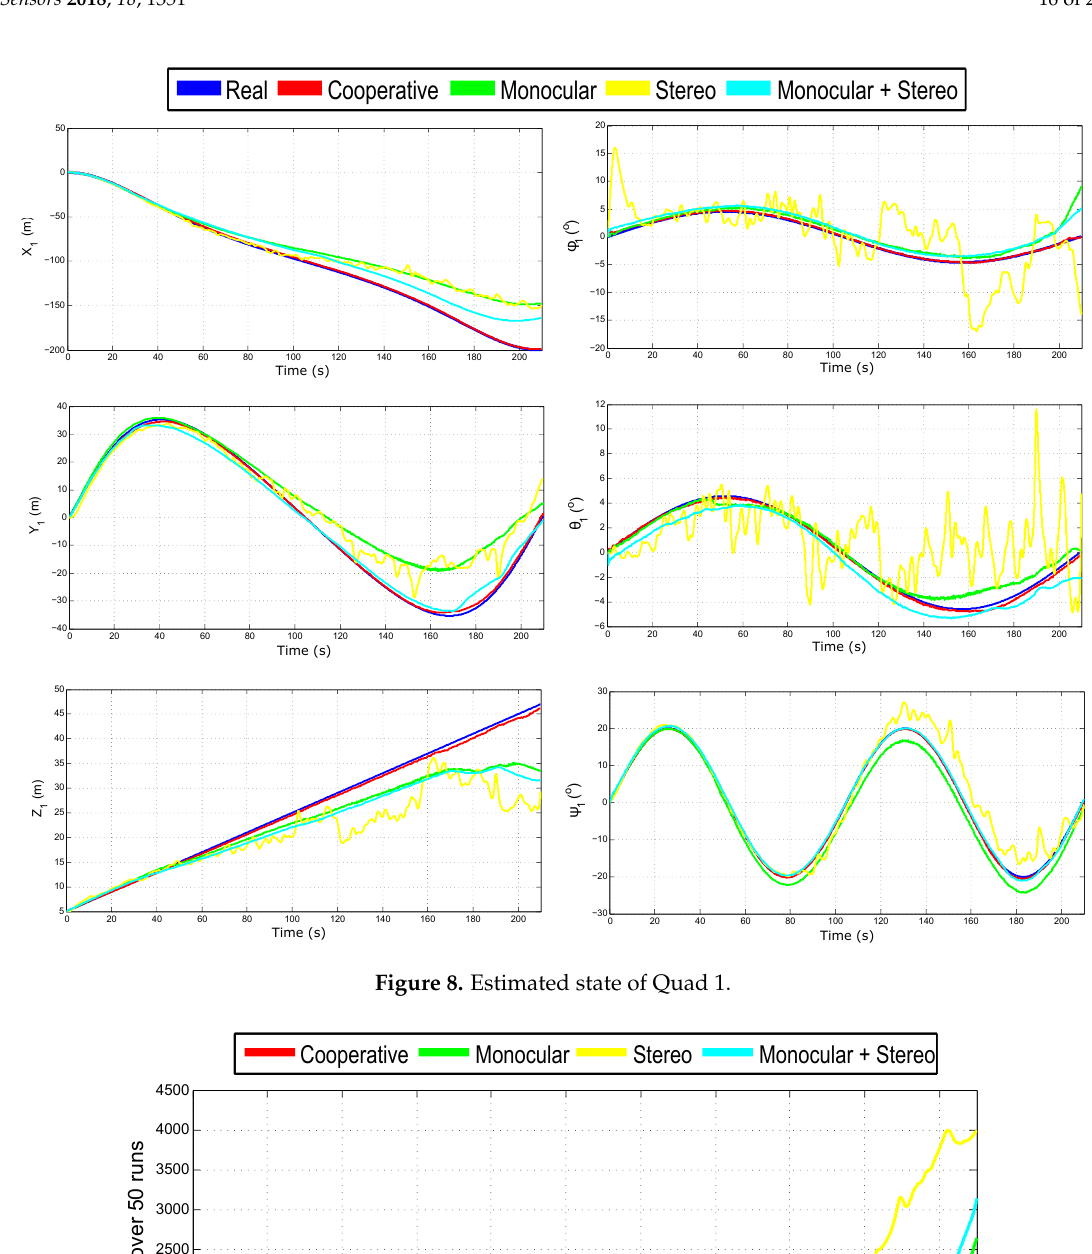
Figure 8. Estimated state of Quad 1.